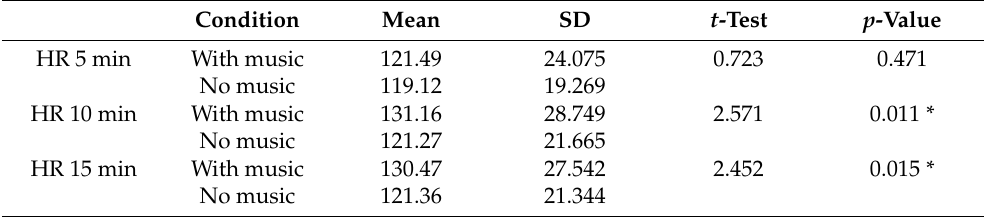
Table 3. Table with and without music for HR differences (Unit: